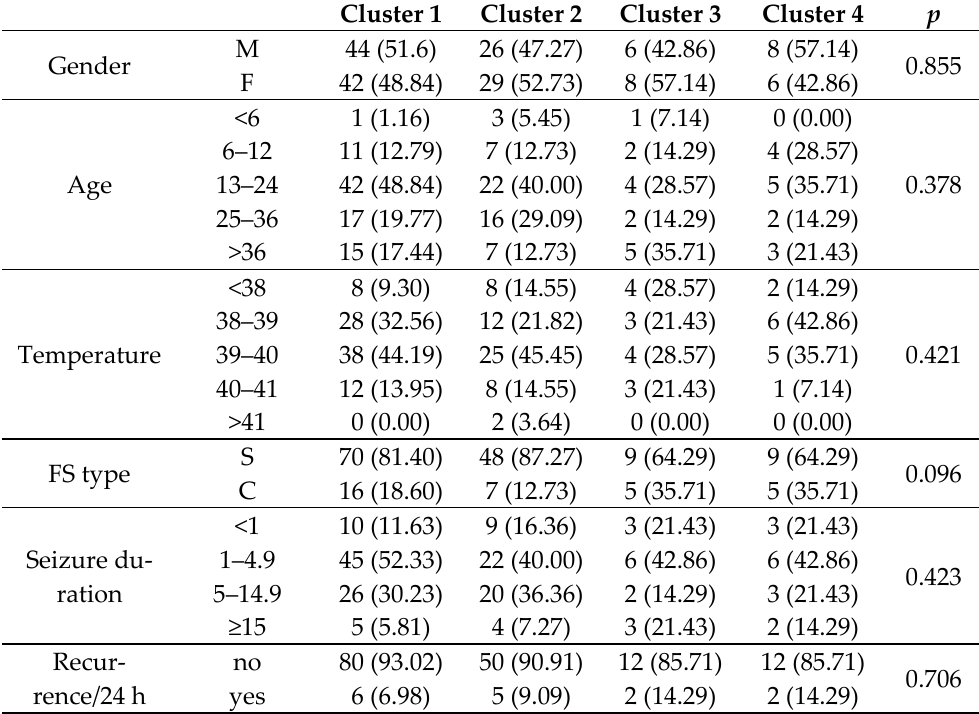
Table 2. Groups profile in terms of demographical and clinical